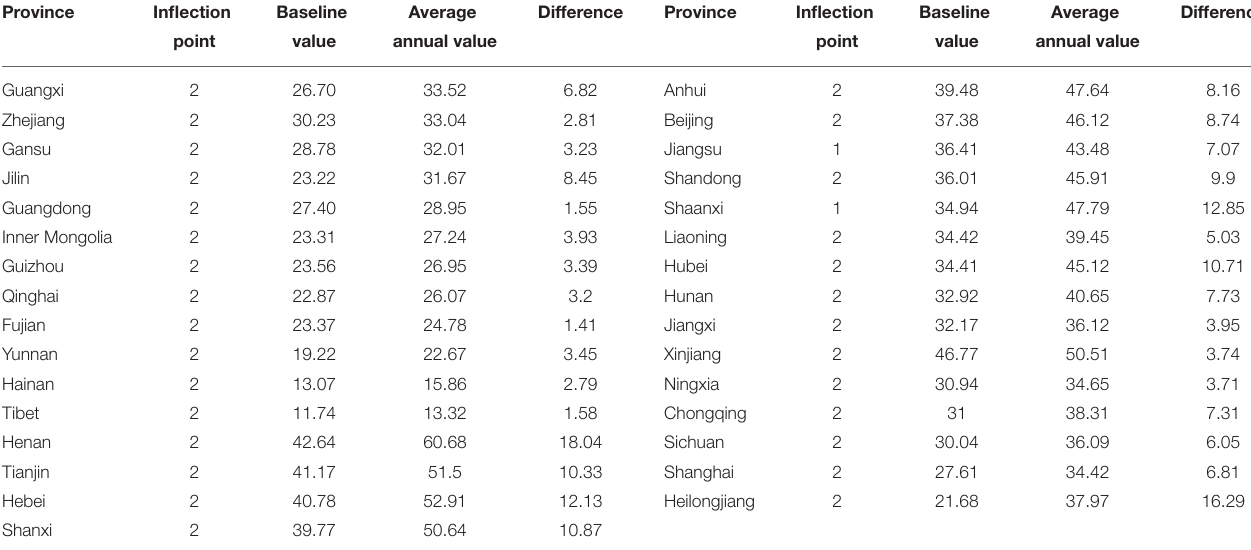
TABLE 1 | PM 2.5 in each province baseline and two-year mean ( µ g/m 3 ).